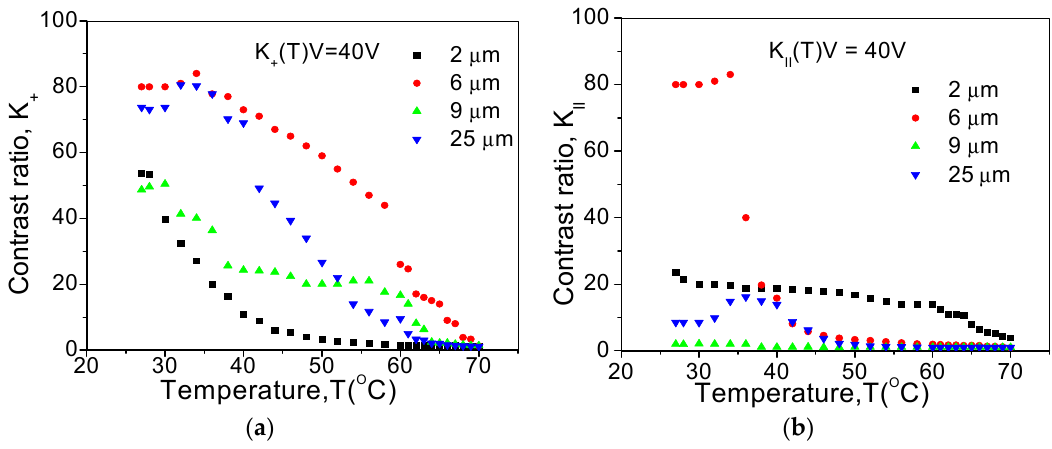
Figure 7. Temperature dependent contrast ratio of SmC* phase (K) in ( a ) crossed and ( b ) parallel polarized states. Measurements are carried out by the application of 40 V in planar-aligned cells filled with KCFLC 10R material, in a cooling process.